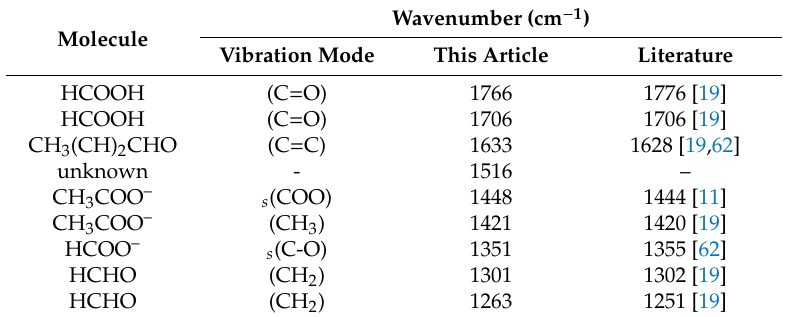
Table 6. Assignment of FTIR bands observed for commercial rutile-type titania samples after adsorption of acetaldehyde.